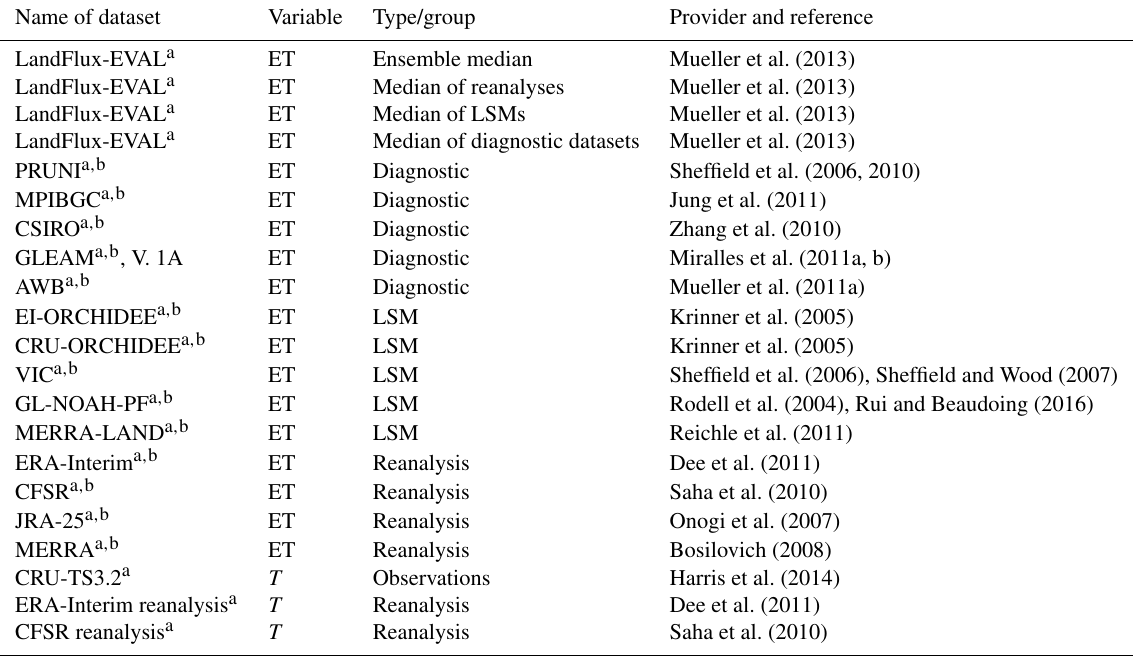
Table 1. Datasets used for model evaluation. LSM: land surface